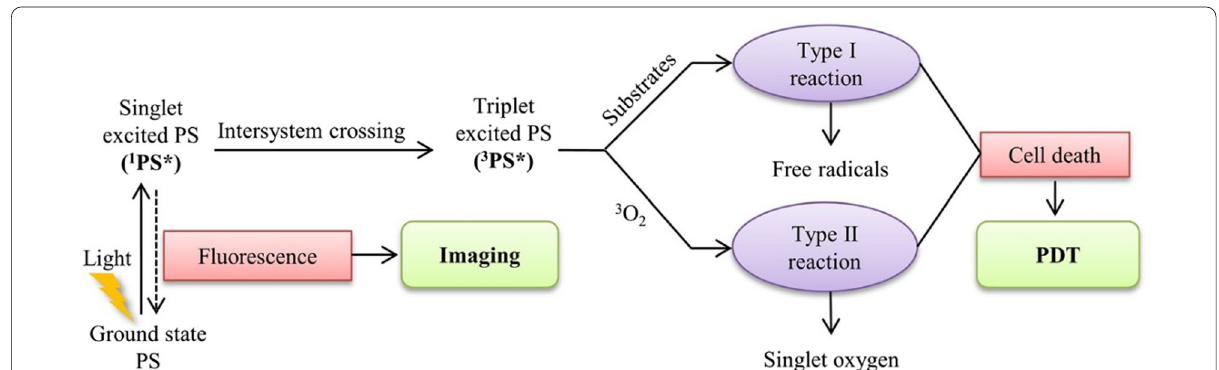
Fig. 2 Schematic drawing of a typical photodynamic reaction